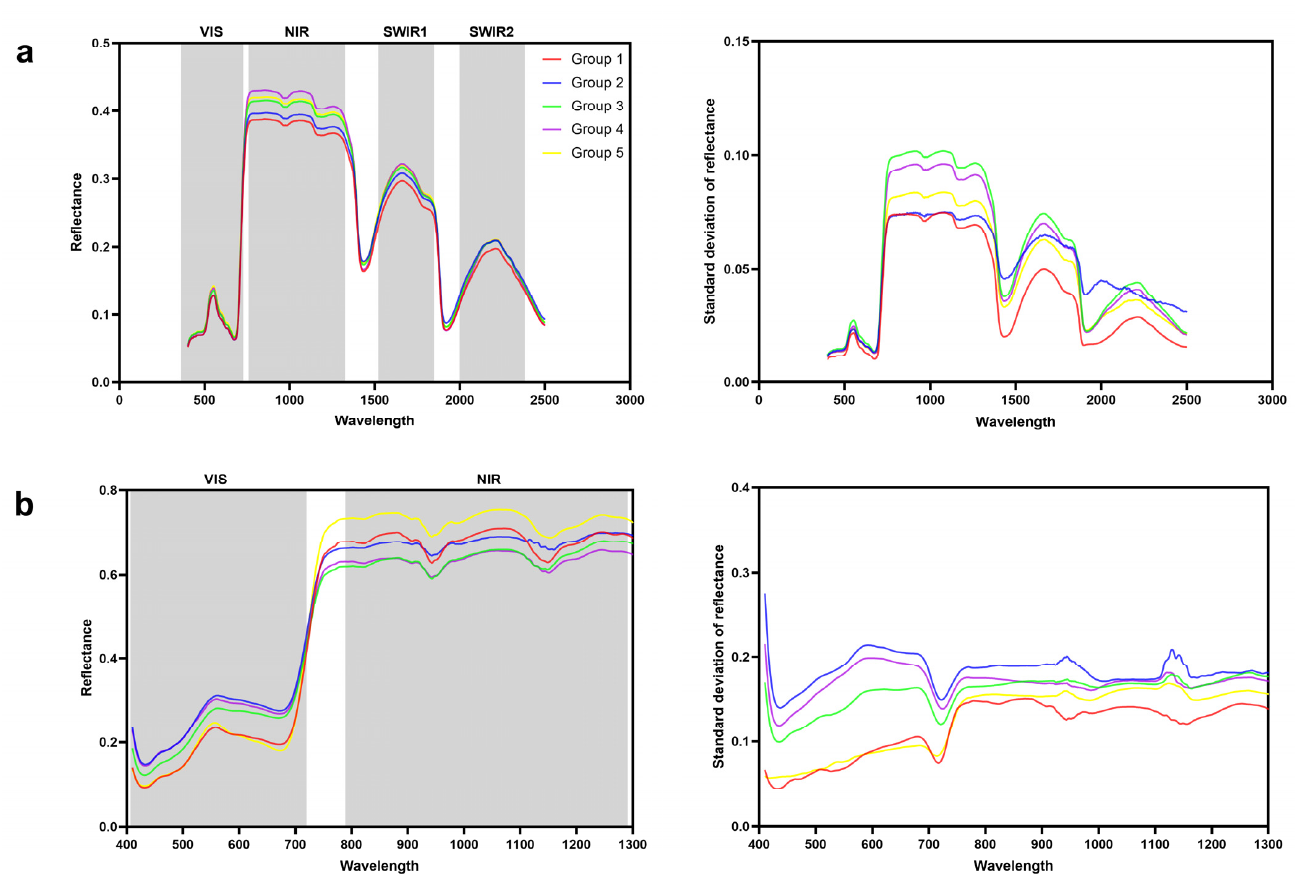
Figure 3. Reflectance variations among the five genotypic groups for ( a ) leaf hyperspectral measurement, and ( b ) canopy hyperspectral measurement. The left panels show mean % reflectance of each group indicate 95% quantiles, and the right panels show the standard deviation of leaf and canopy reflectance.